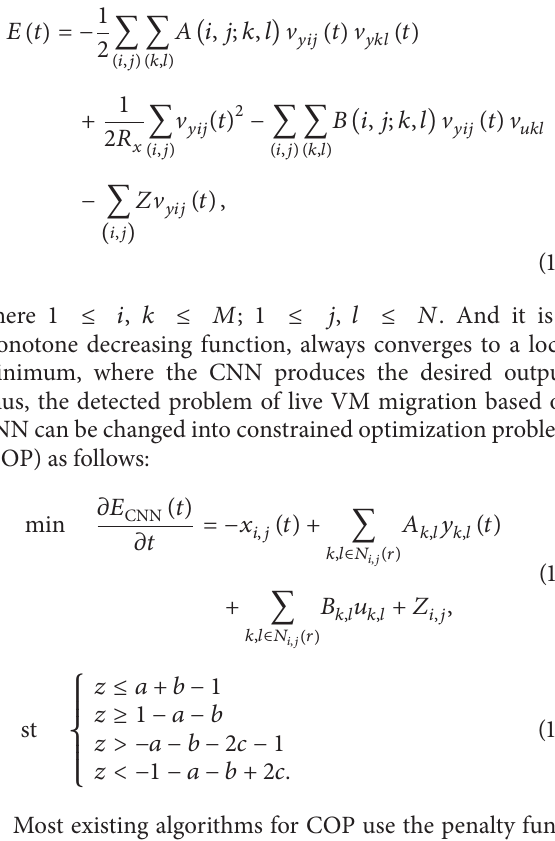
Figure 2: The dynamic trajectory of cell for global